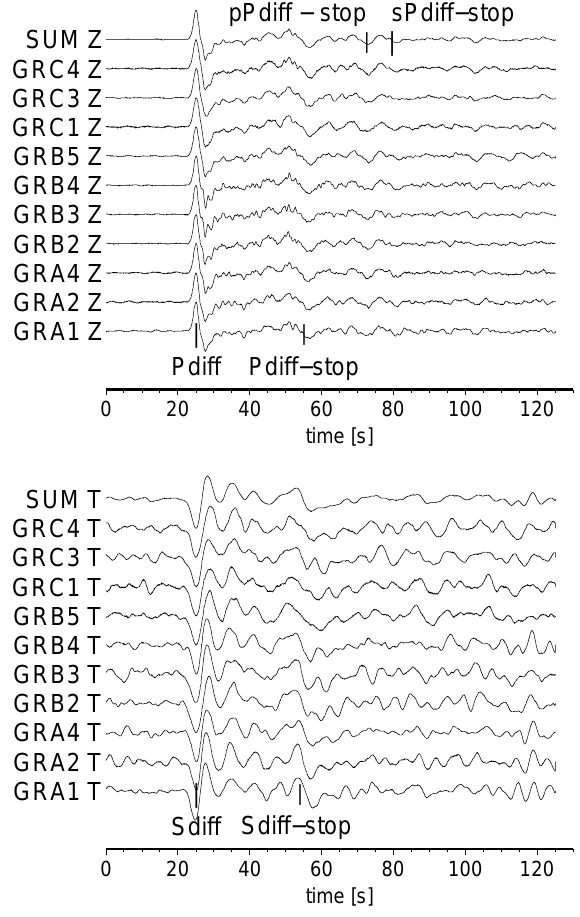
Fig. 5. Raw velocity seismograms at stations of the Gr¨afenberg array, Germany, for the M 7 . 4 Java earthquake on 2 September 2009. Traces are normalised and aligned to the onsets of the P waves (top, vertical component) and of the S waves (bottom, transverse component). The summed trace is on the top of each seismogram ensemble. The phases near 55s are interpreted as the stopping phase ( P diff and S diff ) defining the end of the rupture. The arrivals of the depth phases ( pP diff and sP diff ) related to the stopping phases are indicated on the sum of the vertical components.